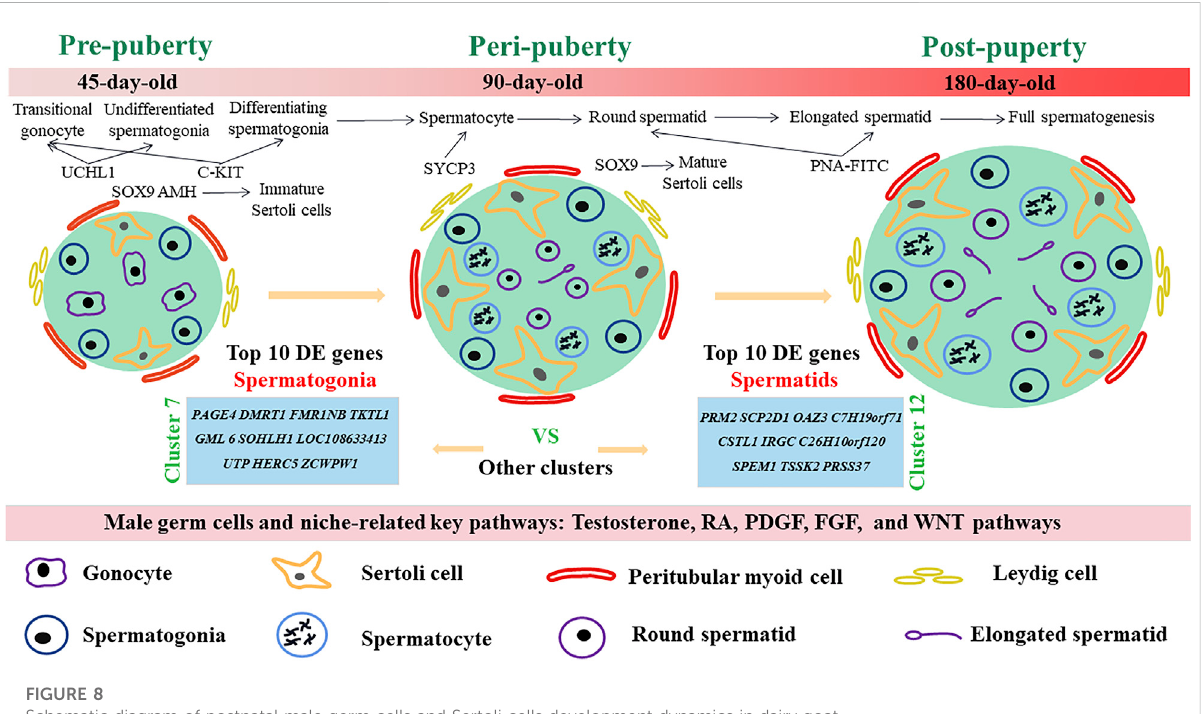
FIGURE 8 Schematic diagram of postnatal male germ cells and Sertoli cells development dynamics in dairy